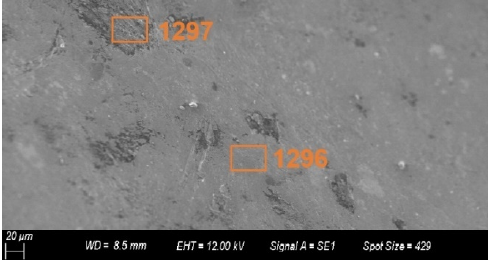
Figure 12. Worn mobile contacts after period in operation on the regulator—( a ) (Contact a) and ( b ) (Contact b).